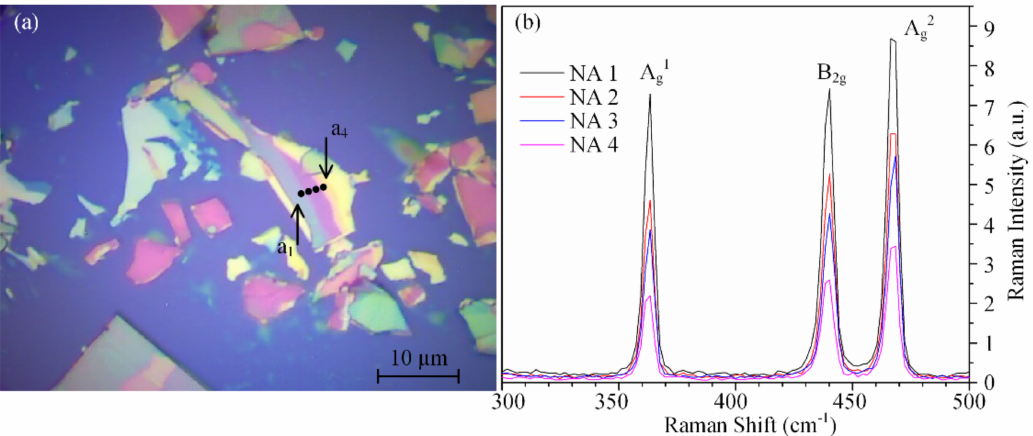
Figure 5. ( a ) Optical image of black phosphorus sample, where a 1 to a 4 are the polarized micro-Raman sampling spots, ( b ) Raman spectra detected from a 1 to a 4 under the NA configuration when ϕ = 0 ◦